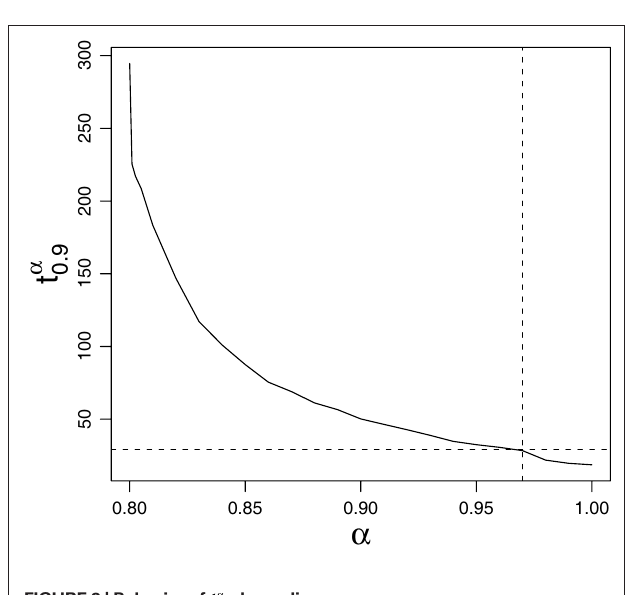
Figure 2 | Behavior of t